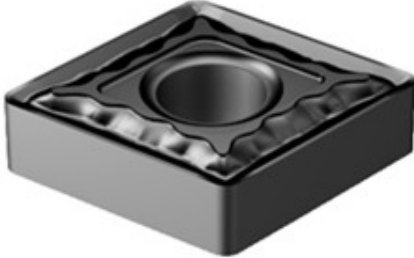
Fig. 2. Photographic view of PVD TiAlN coated